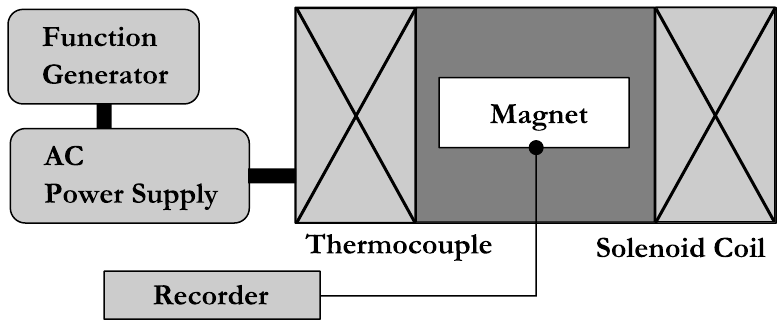
Figure 2. Schematic apparatus of eddy-current measurement